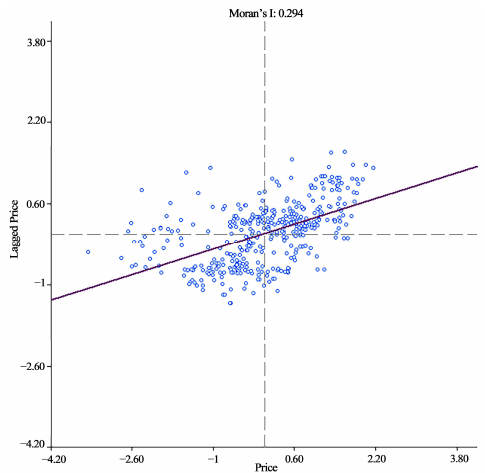
Figure 6. Lisa Scatter Plot Frame. The blue circles represent the correlations between the land price and its spatial lag, while the purple line refers to the linear fit of the scatter plot, the slope of which is the global Moran’s index.